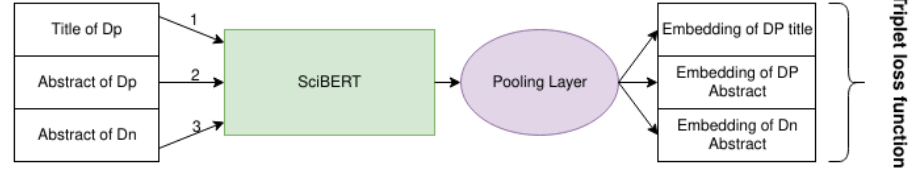
Figure 2. In the picture we show how SciBERT model is trained. Numbers on the input items indicate that they are process